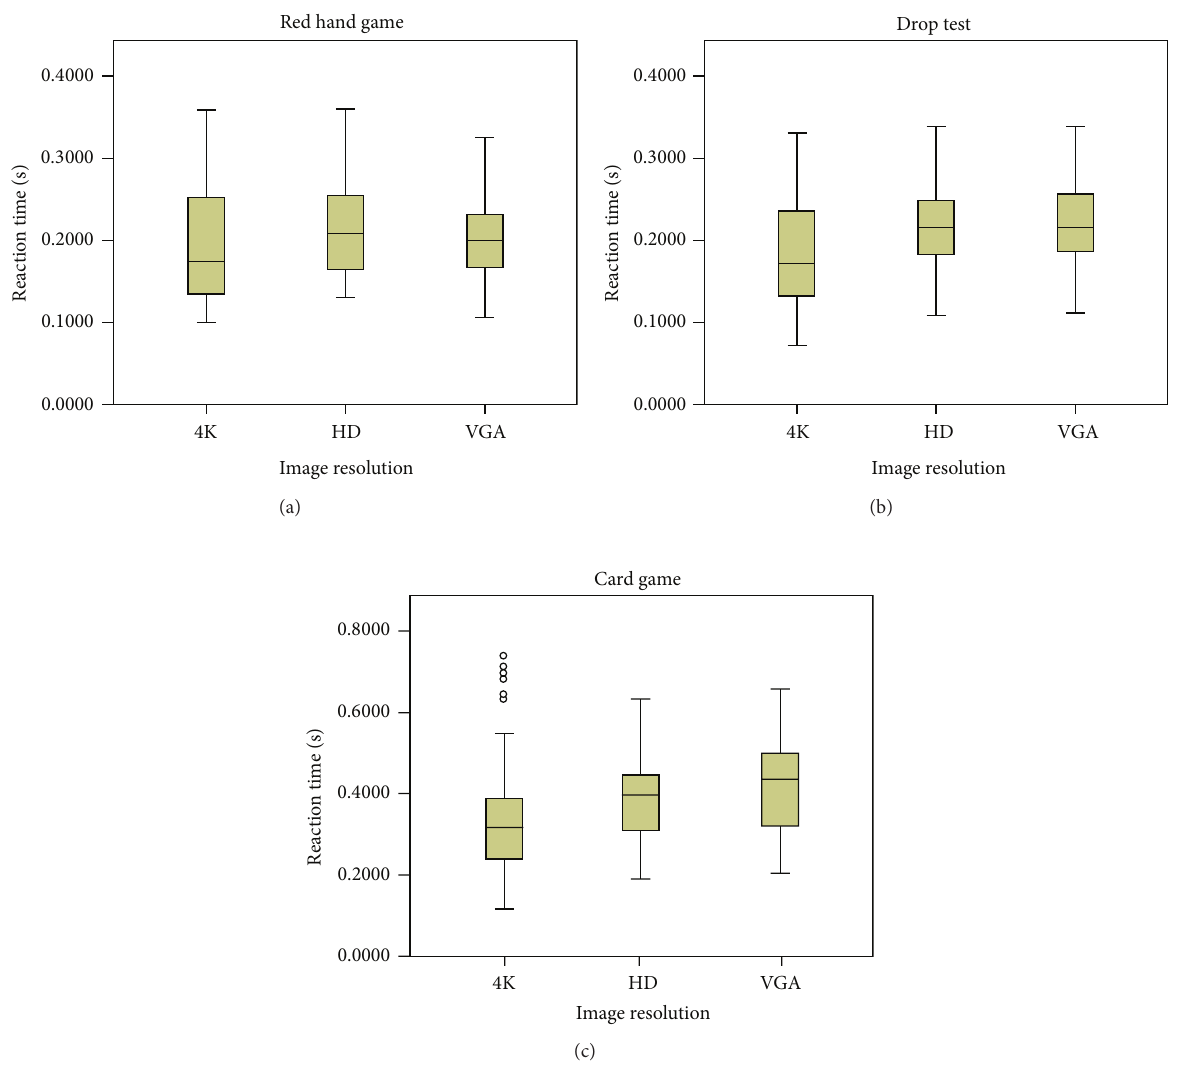
Figure 4: Box diagram of reaction time of